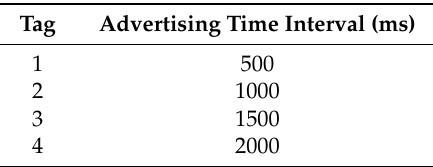
Figure 6. Ground truth path for the case study. Table 1. Advertising time interval for tags.